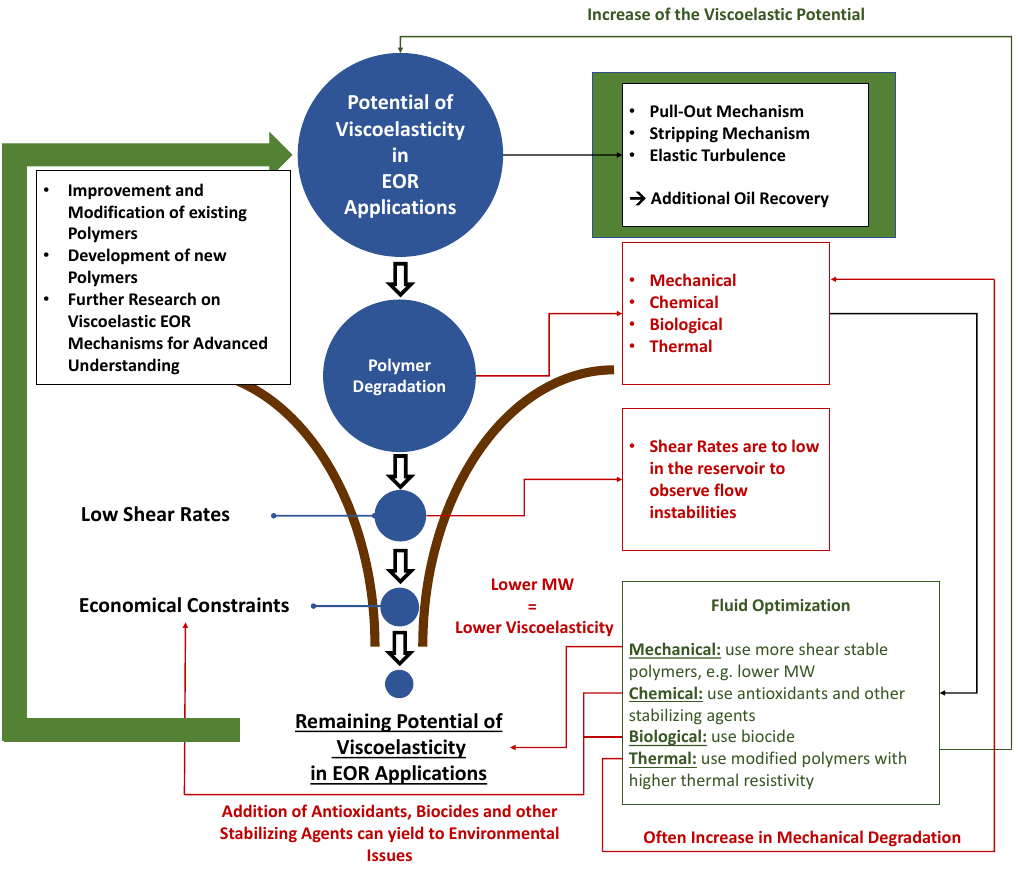
Figure 23. Potential and impacts on the role of polymer viscoelasticity in EOR applications. In contrast to laboratory studies, a decreasing potential is observed taking all impacts and interactions into account. Modification of existing and development of new polymers in combination with further research can drastically improve the viscoelastic influence in polymer